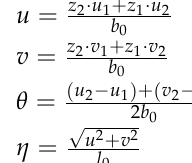
Figure 2. Sectional geometric properties and initial imperfections. Table 2. The measured geometric properties and initial imperfections